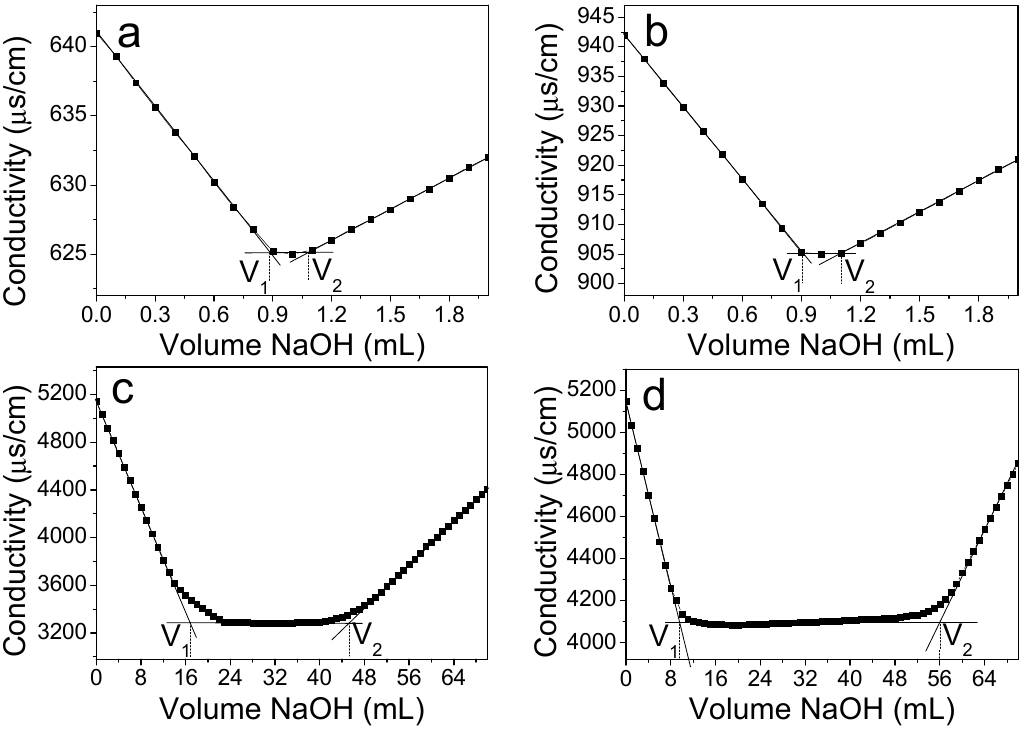
Figure 4. Conductivity titration curve of ( a ) pristine cellulose; ( b ) NaOH/urea-treated cellulose; ( c ) direct TEMPO-oxidized cellulose; and ( d ) NaOH/urea-treated TEMPO-oxidized cellulose.